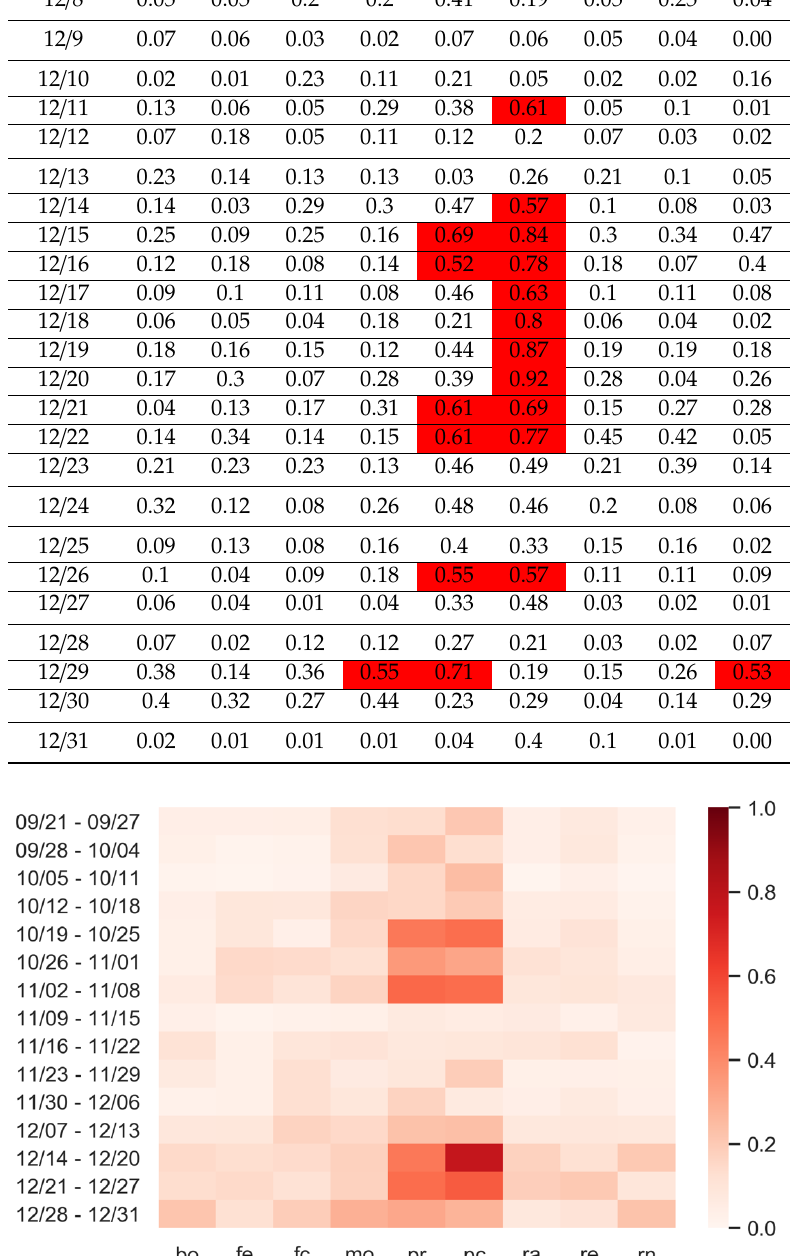
Figure 6. Predictions (2019->2020): heatmap.